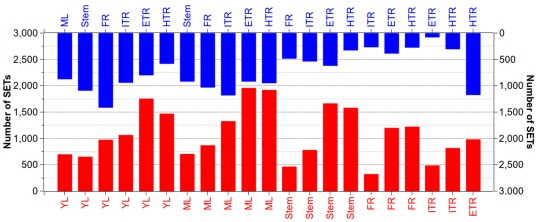
Transcripts specifically expressed between different tissues.Specifically expressed transcripts were quantified. The numbers of DGE transcripts of 21 comparisons between each two samples are shown in blue and red histograms (top vs. bottom).